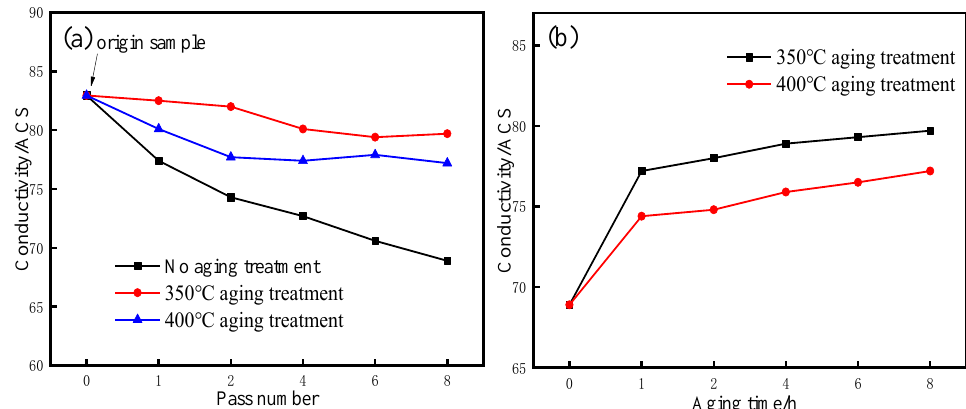
Figure 7. Electrical conductivity curve of the Cu1.5Cr0.1Si alloy after C-path ECAP deformation and aging. (a) Curves of 1-five passes under different aging temperatures (b) 350 °C and 400 °C aging for